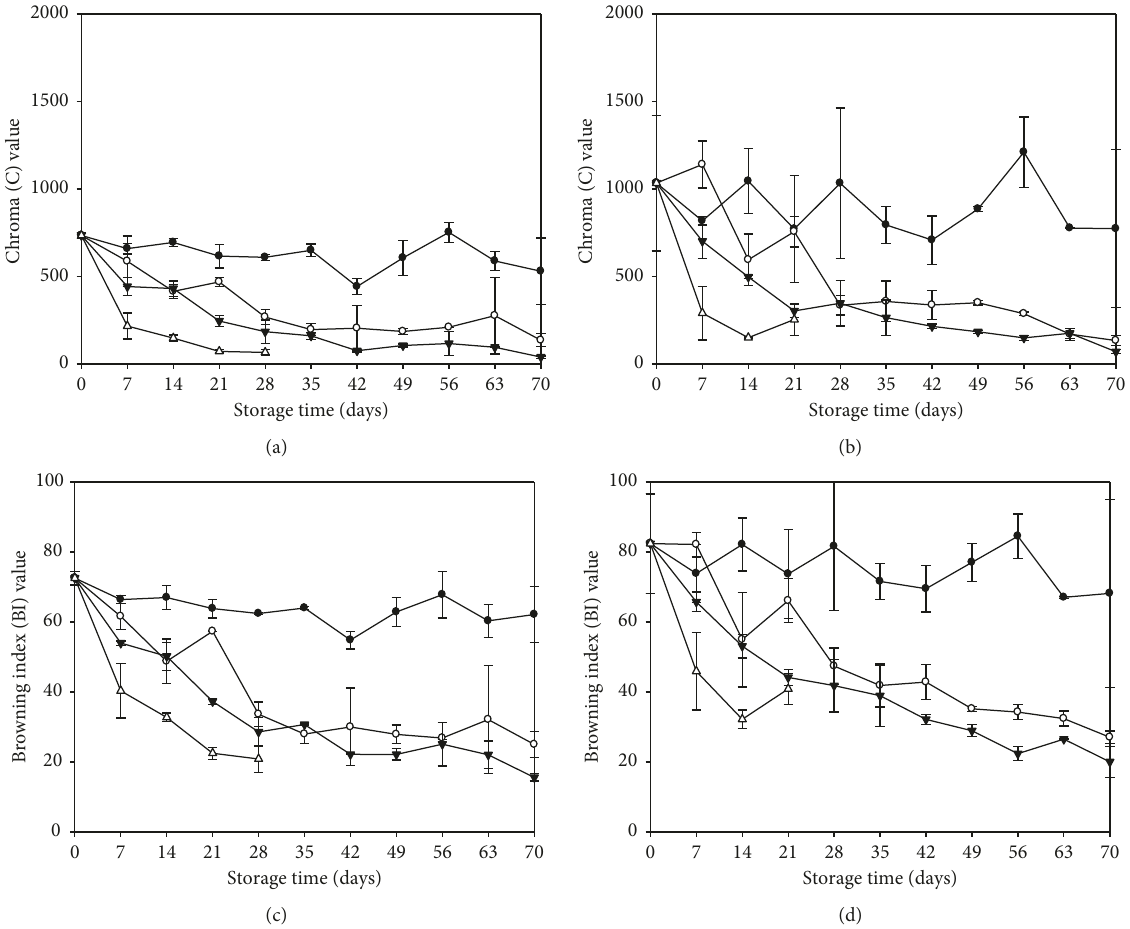
Figure 2: Change of chroma (a, b) and browning index (c, d) in dried persimmon-1 and dried persimmon-2 during storage at different temperatures ( − 20, 5, 12, and 25 ° C) for 70days. Dried persimmon-1 (a, c) and dried persimmon-2 (b, d). • , − 20 ° C; ○ , 5 ° C; ▼ , 12 ° C; △ , 25 ° C.